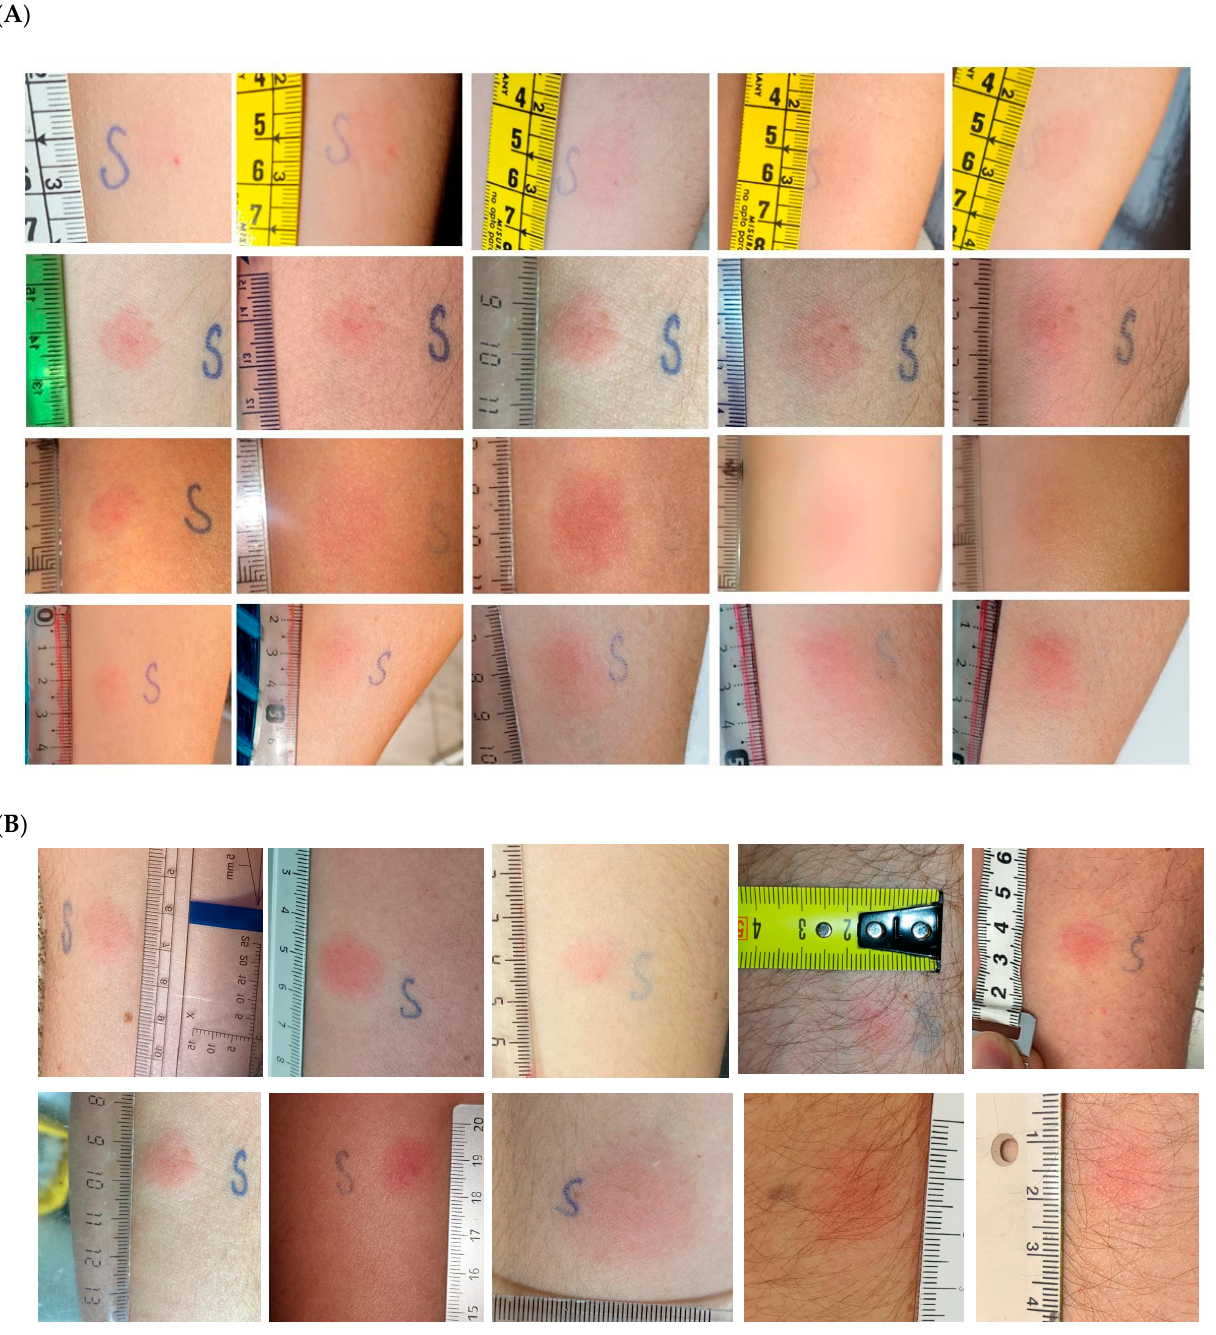
Figure 2. Delayed-type hypersensitivity cutaneous test. ( A ). Representative image of DTH skin test in four immunocom- petent individuals showing reaction (First line: 35y-o woman; Second line: 51y-o woman; Third line: 48 y-o woman; Fourth line 49y-o. woman) at 6 h (first column), 12 h (second column), 24 h (third column), 36 h (fourth column), and 48 h (fifth column). ( B ). Representative image of DTH skin test in five immunocompetent individuals. Images show in the first line the skin responses 12 h after DTH performed twenty days after first dose. In second line images show the skin reaction 12 h after DTH performed fifteen days after second dose.